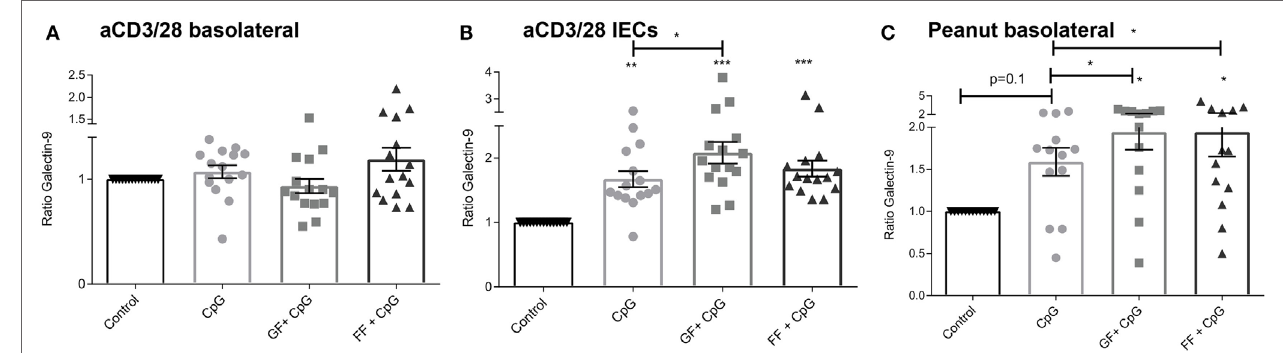
FigUre 5 | Increased galectin-9 production by intestinal epithelial cells (IECs) upon apical exposure to CpG oligodeoxynucleotides in the presence or absence of oligosaccharides. In the aspecific co-culture model, no differences in basolateral galectin-9 were observed after 24 h (a) . Exposure of IECs to oligosaccharides alone did not influence galectin-9 levels, while CpG exposure influenced galectin-9 release by IECs after 48 h, which was further enhanced by short-chain galacto-oligosaccharides and long-chain fructo-oligosaccharides (scGOS/lcFOS) (GF), but not by scFOS/lcFOS (FF) (B) . In the peanut-specific model, both oligosaccharide mixtures further enhanced galectin-9 concentrations (c) . Data represent n = 15 peanut-allergic patients, mean ± SEM, * P < 0.05, ** P < 0.01, *** P < 0.001 by one-way